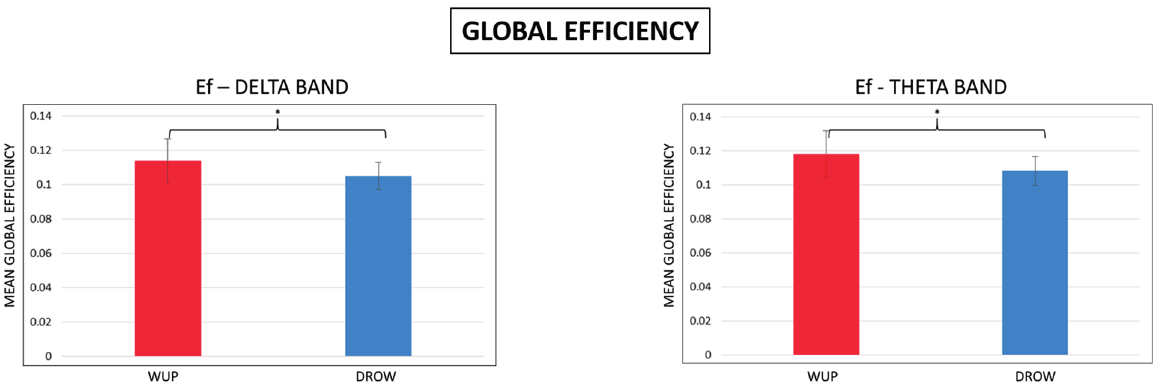
Figure 7. Mean Global Efficiency (Eg) in the delta and theta bands. Note that the Eg